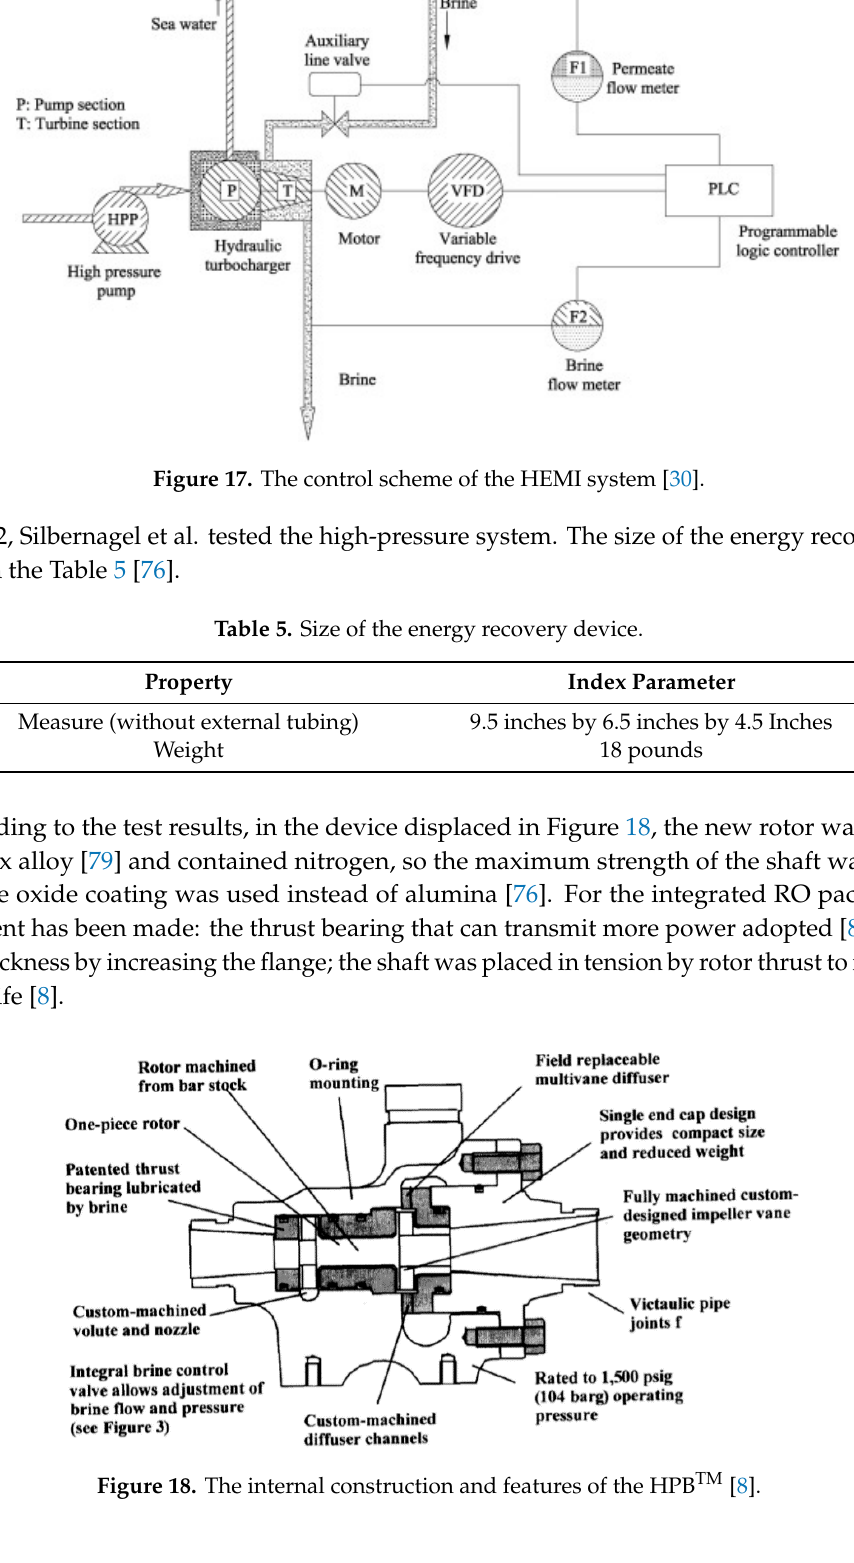
Table 6. Hydraulic assumptions for model calculations [ Error! Reference source not found. ]. Operating Conditions